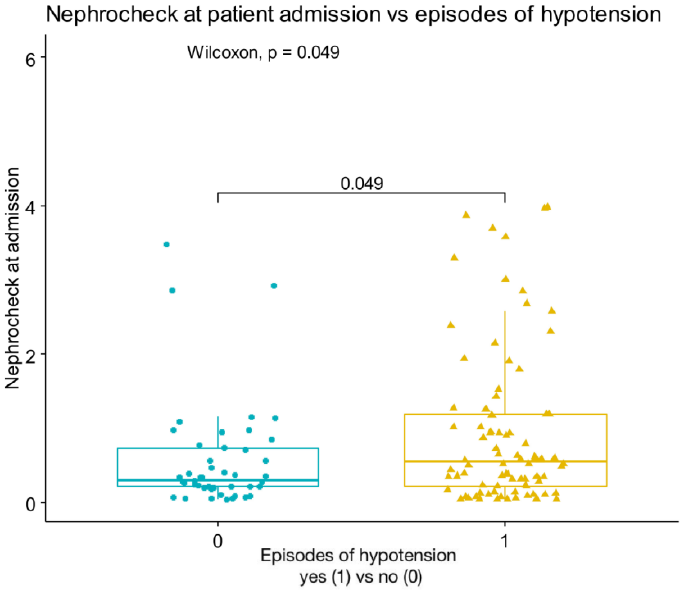
Figure 2. Association between NephroCheck at ICU admission and progression or regression of AKI.